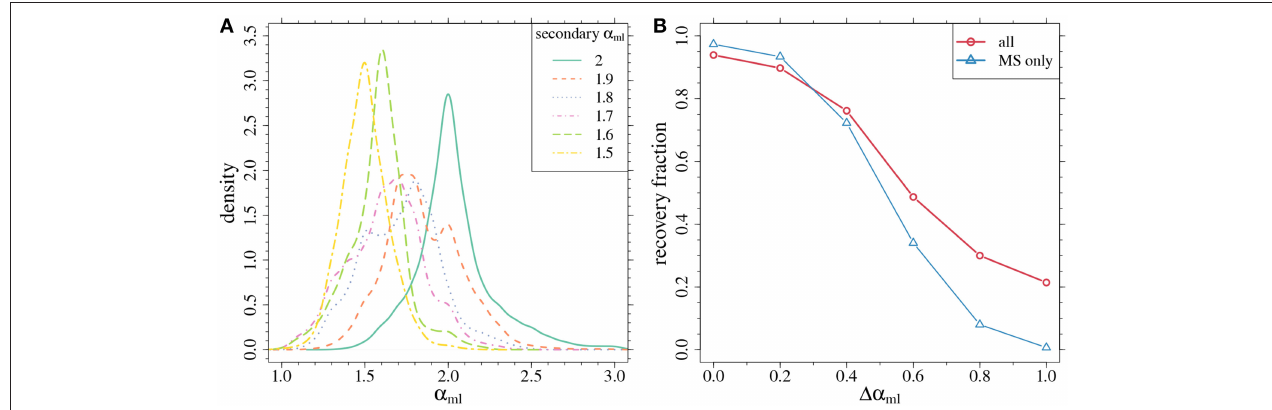
FIGURE 6 | (A) : density of probability of the recovered mixing-length value when a common α ml is imposed in addition to the constraint of common age and original chemical composition. (B) : fraction of systems with a valid mixing-length value fit. The circles identify all the solutions, while triangles correspond only to MS cases.